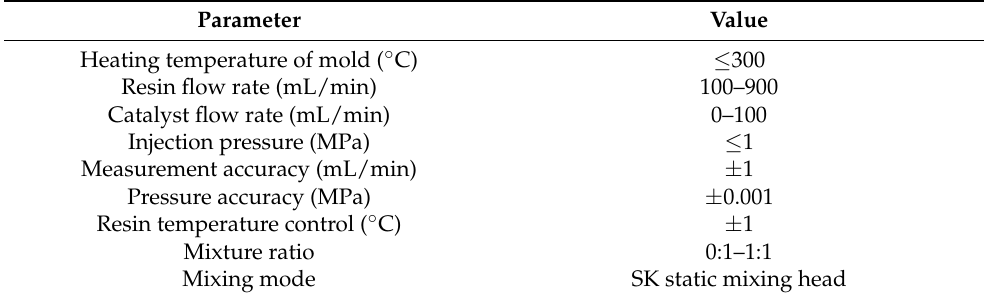
Table 2. Main technical parameters of in situ polymerization injection molding